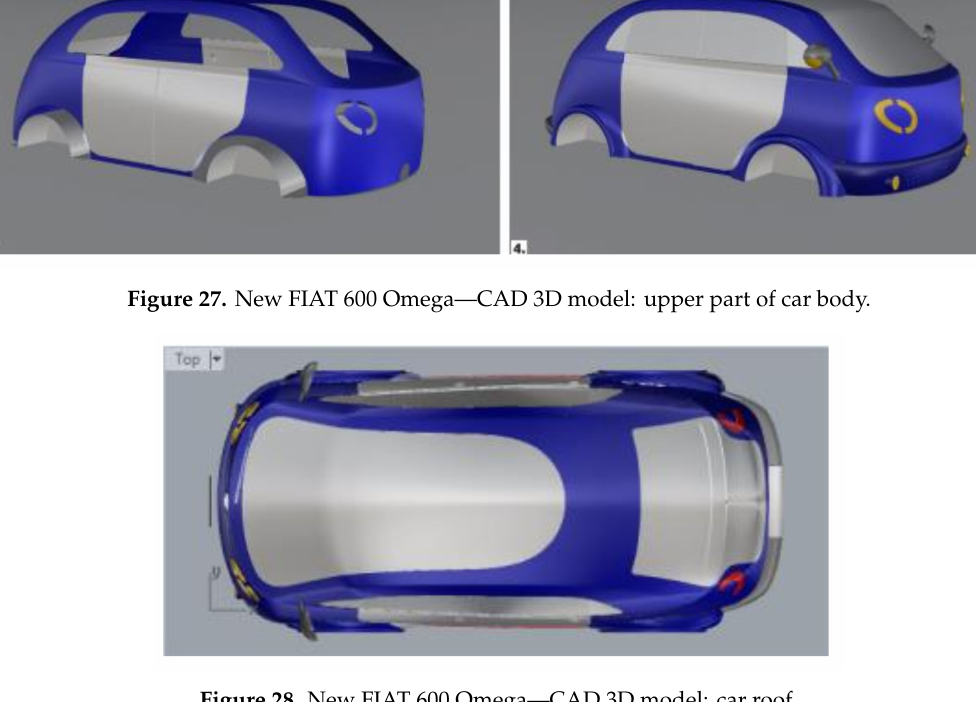
Figure 28. New FIAT 600 Omega—CAD 3D model: car roof.